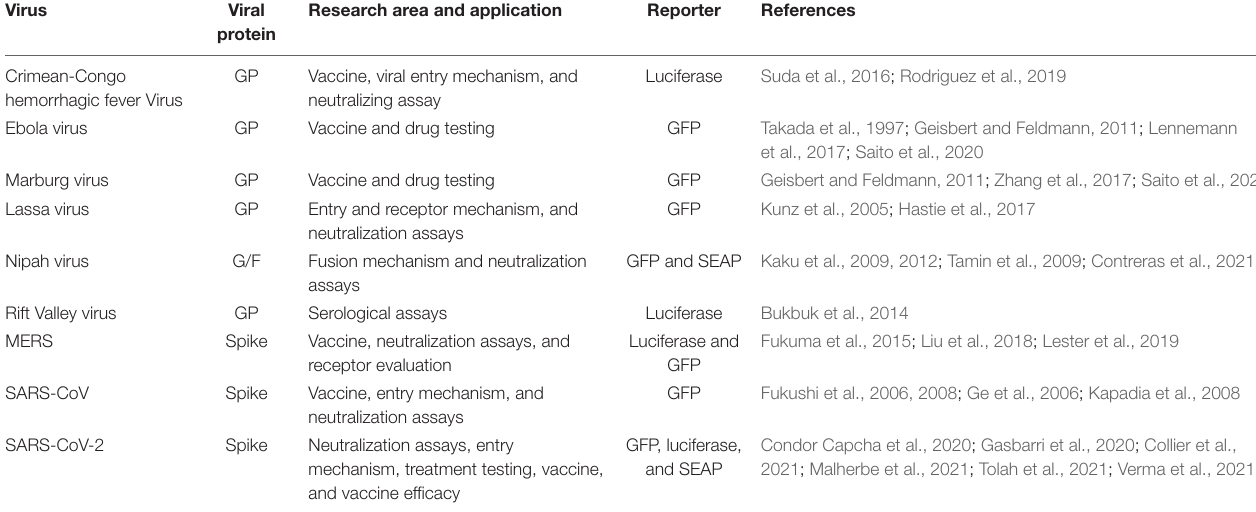
TABLE 1 | Application of pseudotyped Vesicular Stomatitis Virus (VSV). Virus Viral